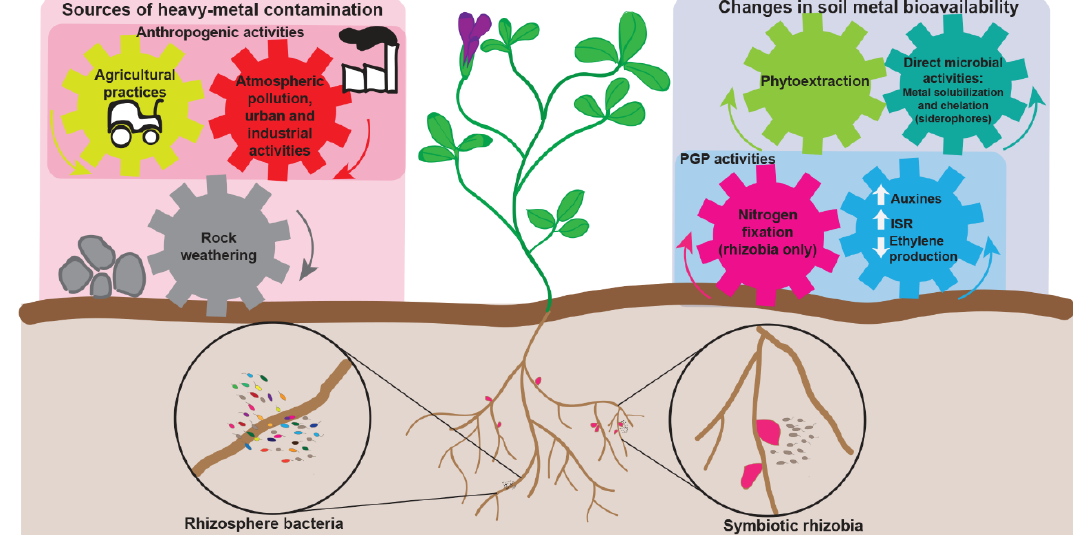
Figure 1. The multiple roles of bacteria in helping plants cope with heavy metals. Plant-associated bacteria may have various roles in both phytostabilization and plant growth. They may influence metal solubility by directly producing molecules for metal chelation (e.g., siderophores), or by influencing plant root growth, resulting in increased production of root exudates. Moreover, both rhizospheric and endophytic bacteria can positively affect plant growth by producing phytohormone molecules (e.g., auxins), alleviating plant stress (e.g., plant ethylene production), or through nitrogen fixation. This latter activity is especially relevant when leguminous plants and their rhizobial microsymbionts are considered. PGP: Plant growth promotion.